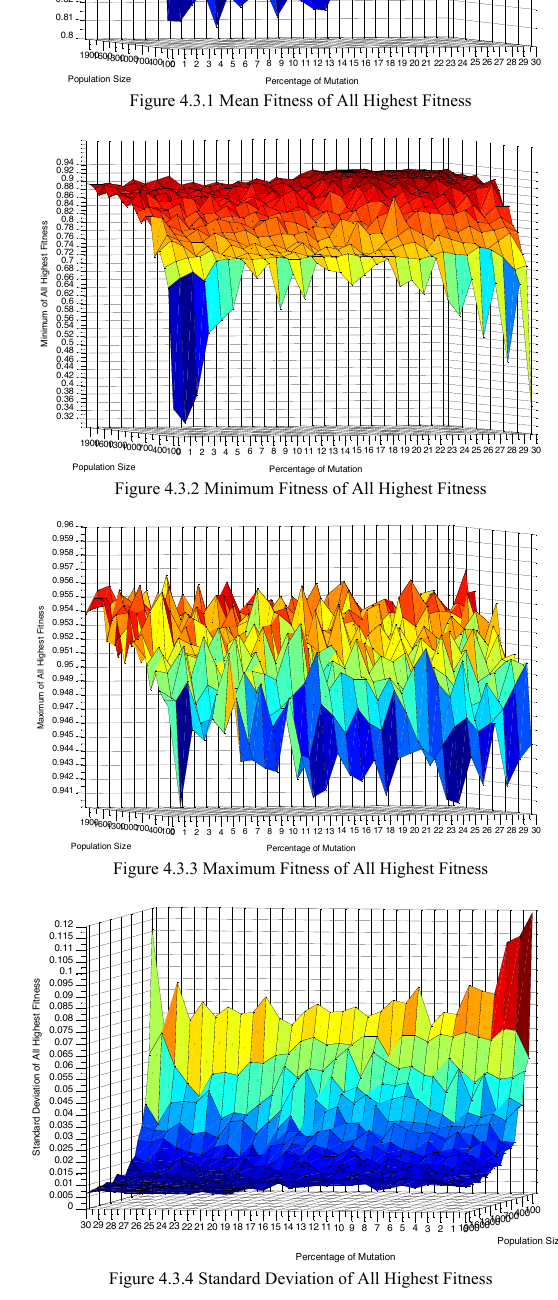
Figure 4.2.4 Standard Deviation of All Highest Fitness Figure 4.2 Total Percentage of Mutation and Crossover is 20% (Mutation over Crossover)